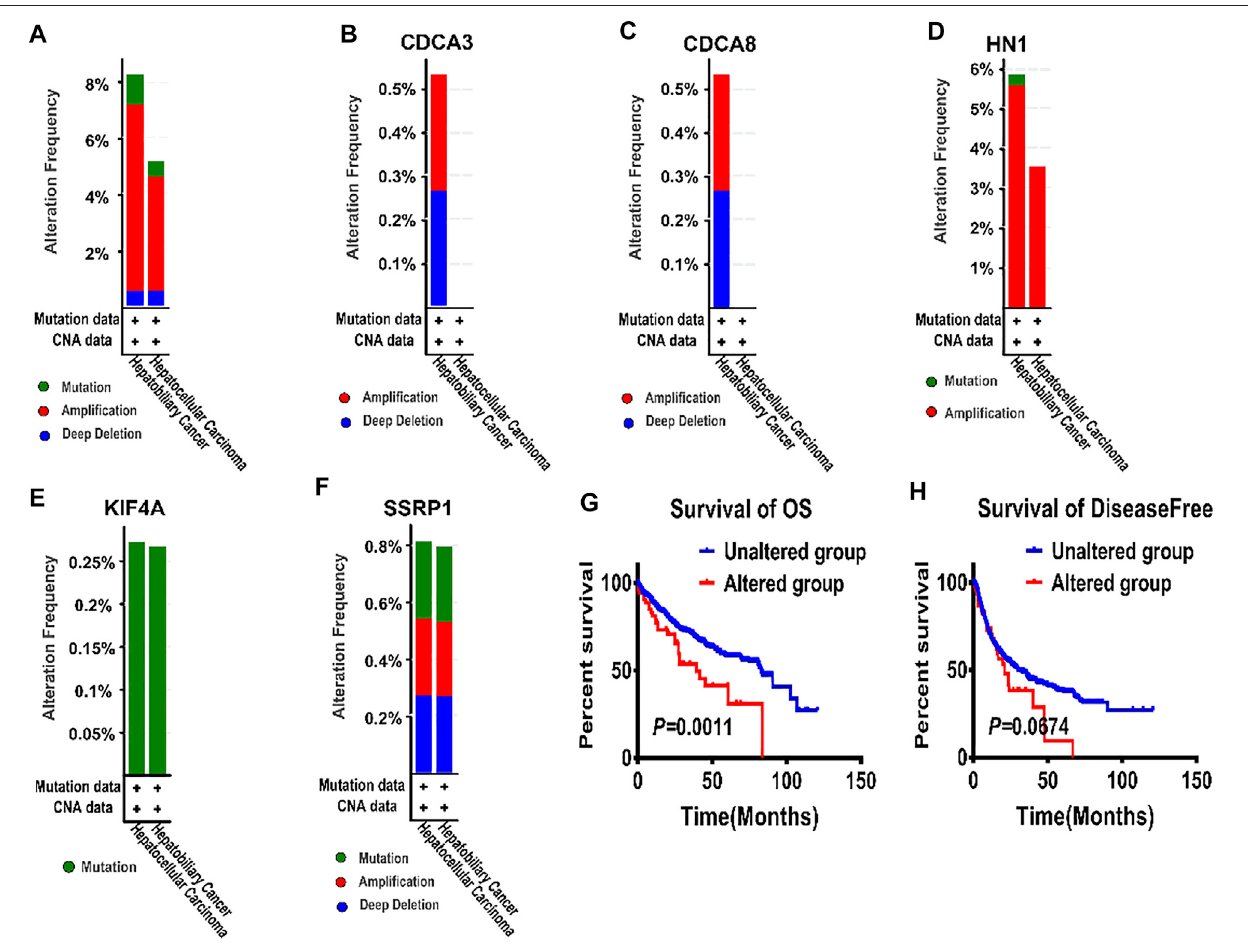
FIGURE 4 | The alterations of E2F target genes in tumor tissues from cBioportal database (A) All alteration types across fi ve genes in patients with hepatocellular carcinoma. (B – F) Genetic alterations of CDCA3, CDCA8, HN1, KIF4A, and SSRP1 were respectively described in (B – F) with speci fi c alteration frequencies (G) The overall survival of hepatocellular carcinoma patients in unaltered and altered groups. (H) The disease-free survival of hepatocellular carcinoma patients in unaltered and altered groups.